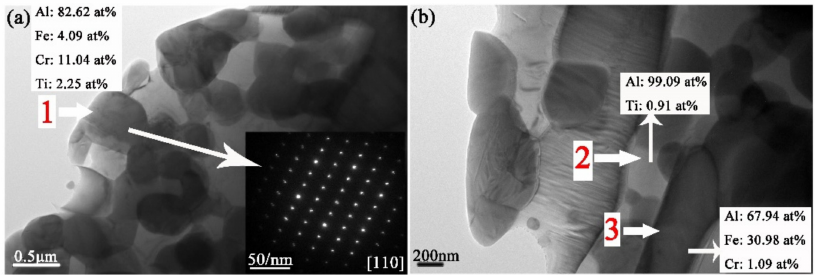
Figure 9. TEM of the sintered samples with sintering temperature 640 ◦ C: ( a ) lower amplification; ( b ) higher amplification.